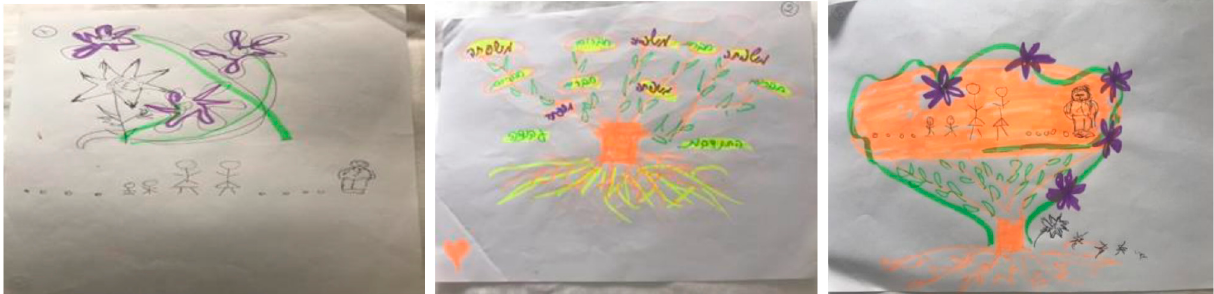
Figure 3. Altering the placement and size of the stress image within the integrated drawing.